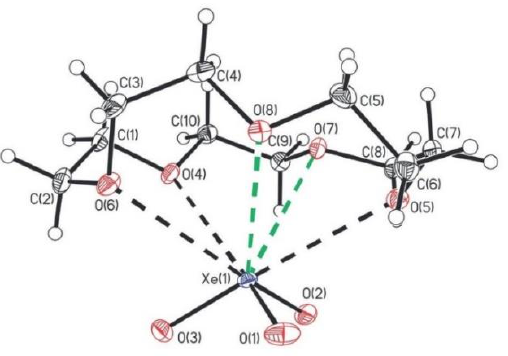
Figure 15. Side-on view of the structural unit in the crystal structure of (CH 2 CH 2 O) 5 XeO 3 . Copyright